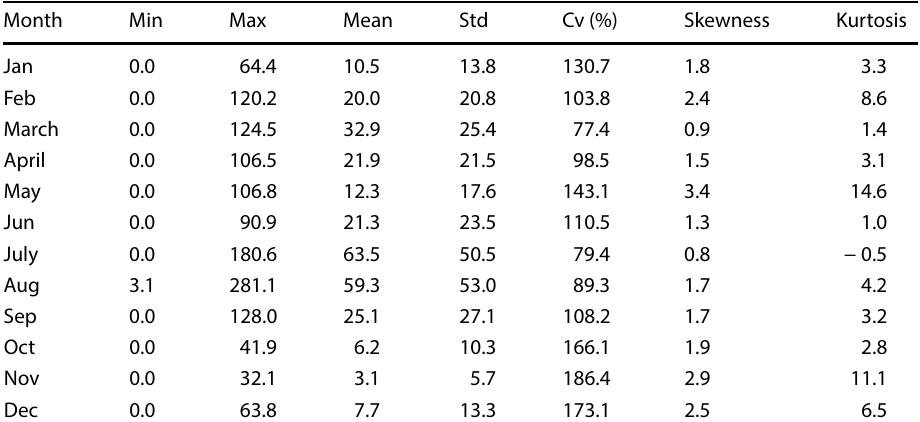
Table 3 Statistical information of rainfall data for Saidu Sharif station from 1960 to 2020 Source : Pakistan Meteorological